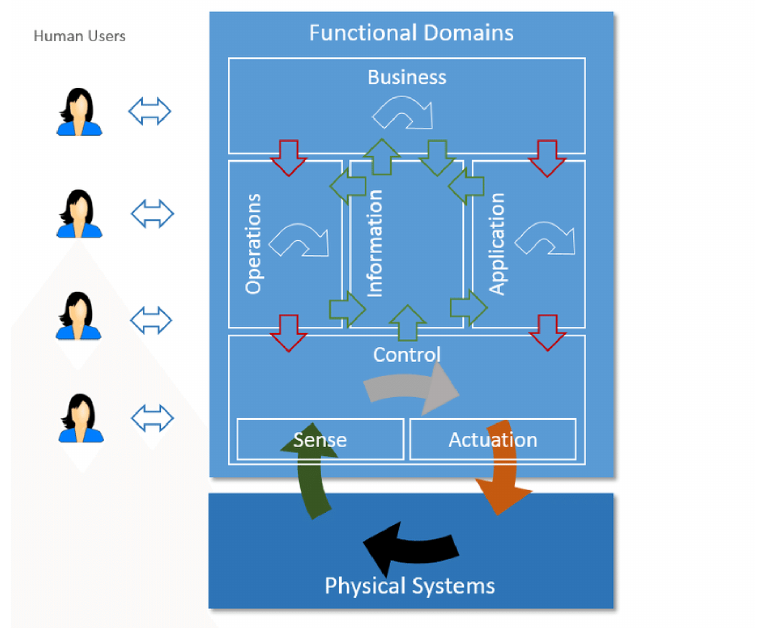
Figure 5. IIRA domains (Reprinted with permission from [11]. Copyright 2019 Object Manage- ment